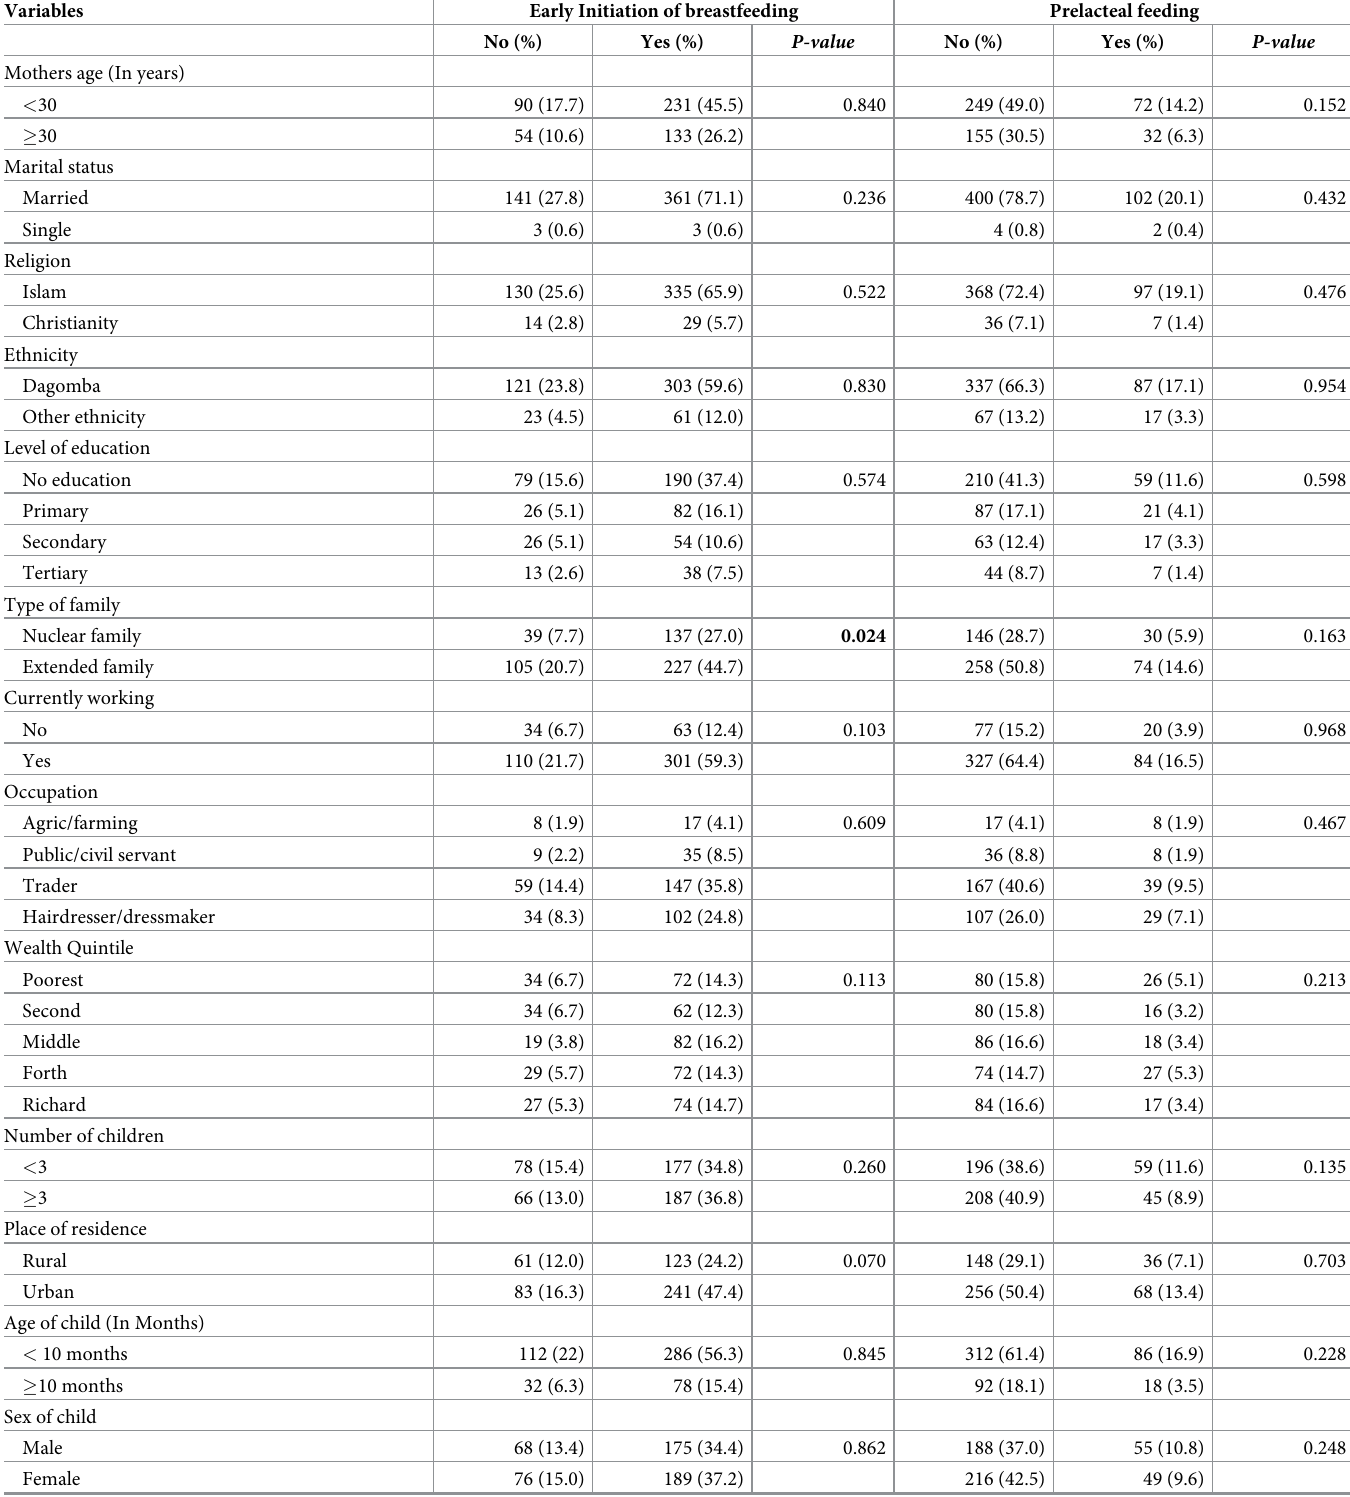
Table 1. Distribution of respondent’s characteristics by early initiation of breastfeeding and prelacteal